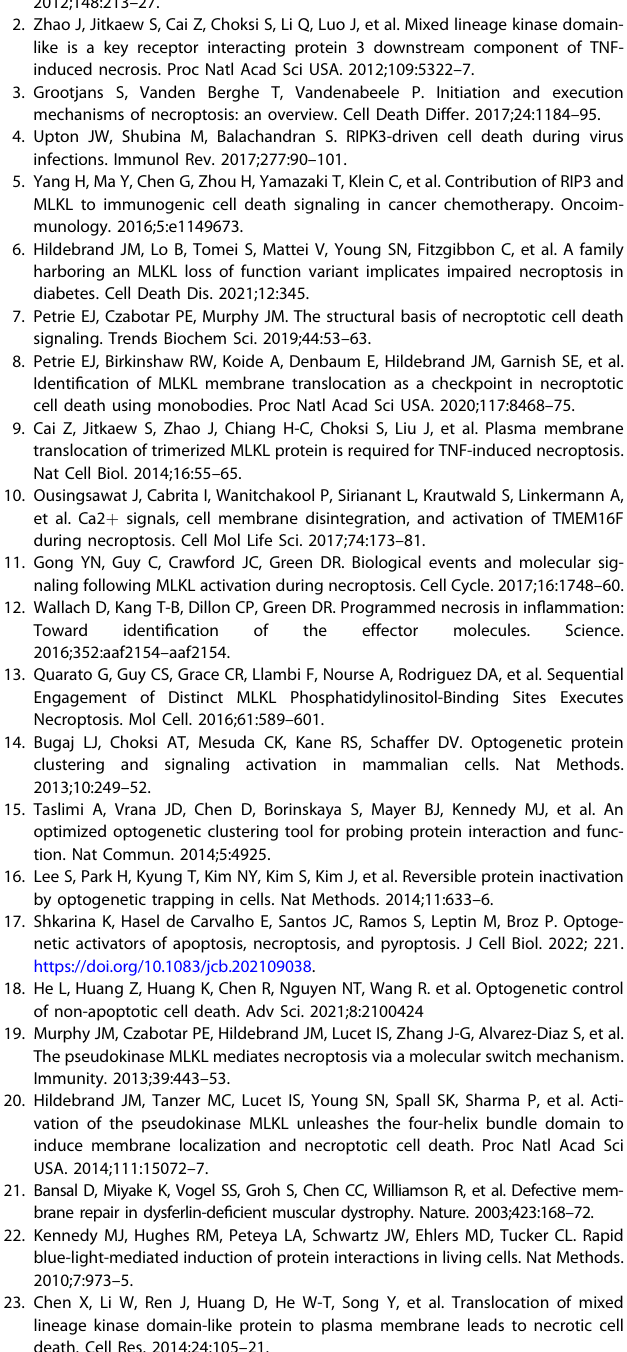
Table 1. Additional datasets used in the analysis for the current study are available from the corresponding author on reasonable